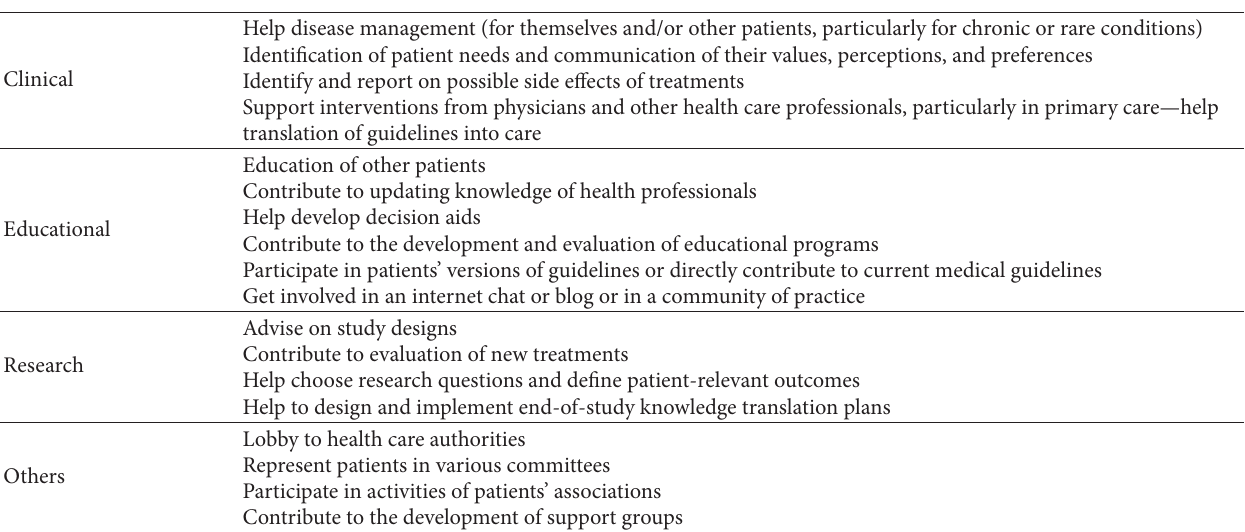
Table 1: Domains and some possible roles of expert